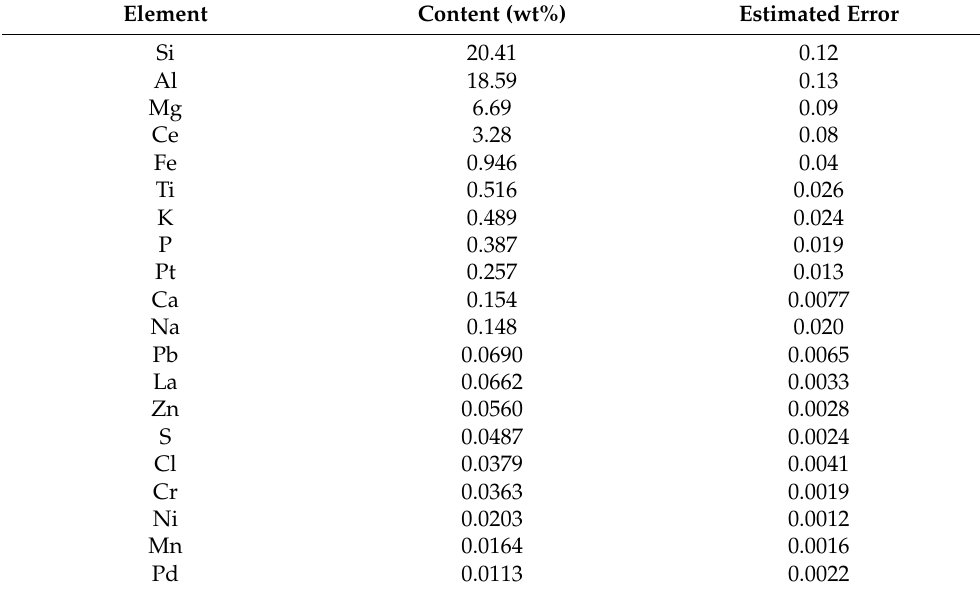
Table 1. Elemental chemical composition of the SACC